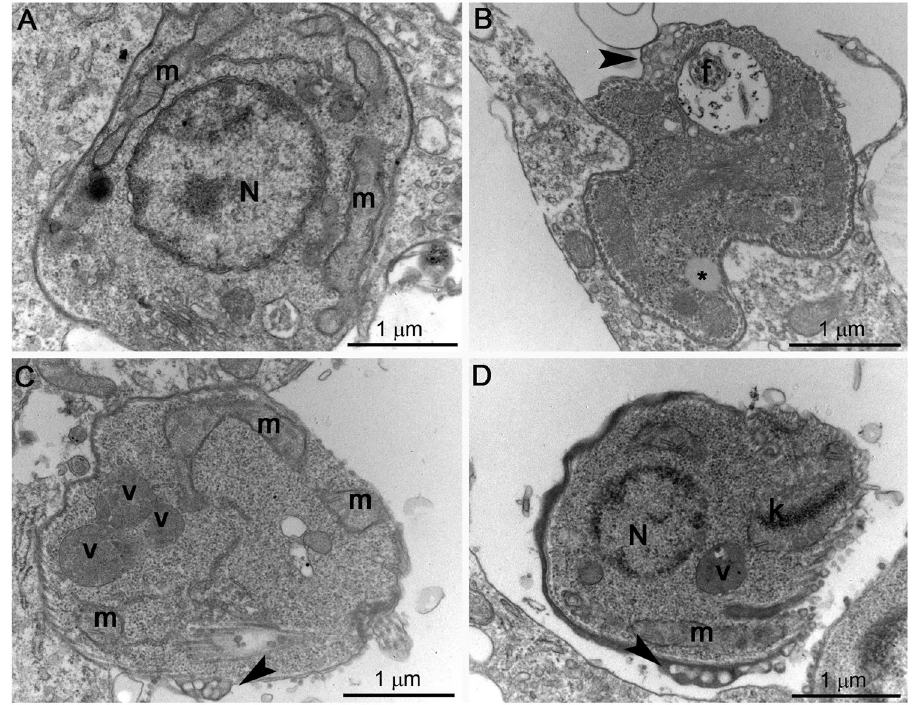
Figure 13. Ultrathin section of L. amazonensis intracellular amastigotes treated with 1 µM of SBC 40 for 48 h. Parasites treated with SBC40 appeared with drastic alterations in the plasma membrane ( B – D , arrowhead), mitochondrial swelling ( C ), presence of autophagosome-like vacuoles ( C , D ), and disorganization of the kinetoplast ( D ). N nucleus, m mitochondrion, f flagellum, k kinetoplast, v autophagosome-like